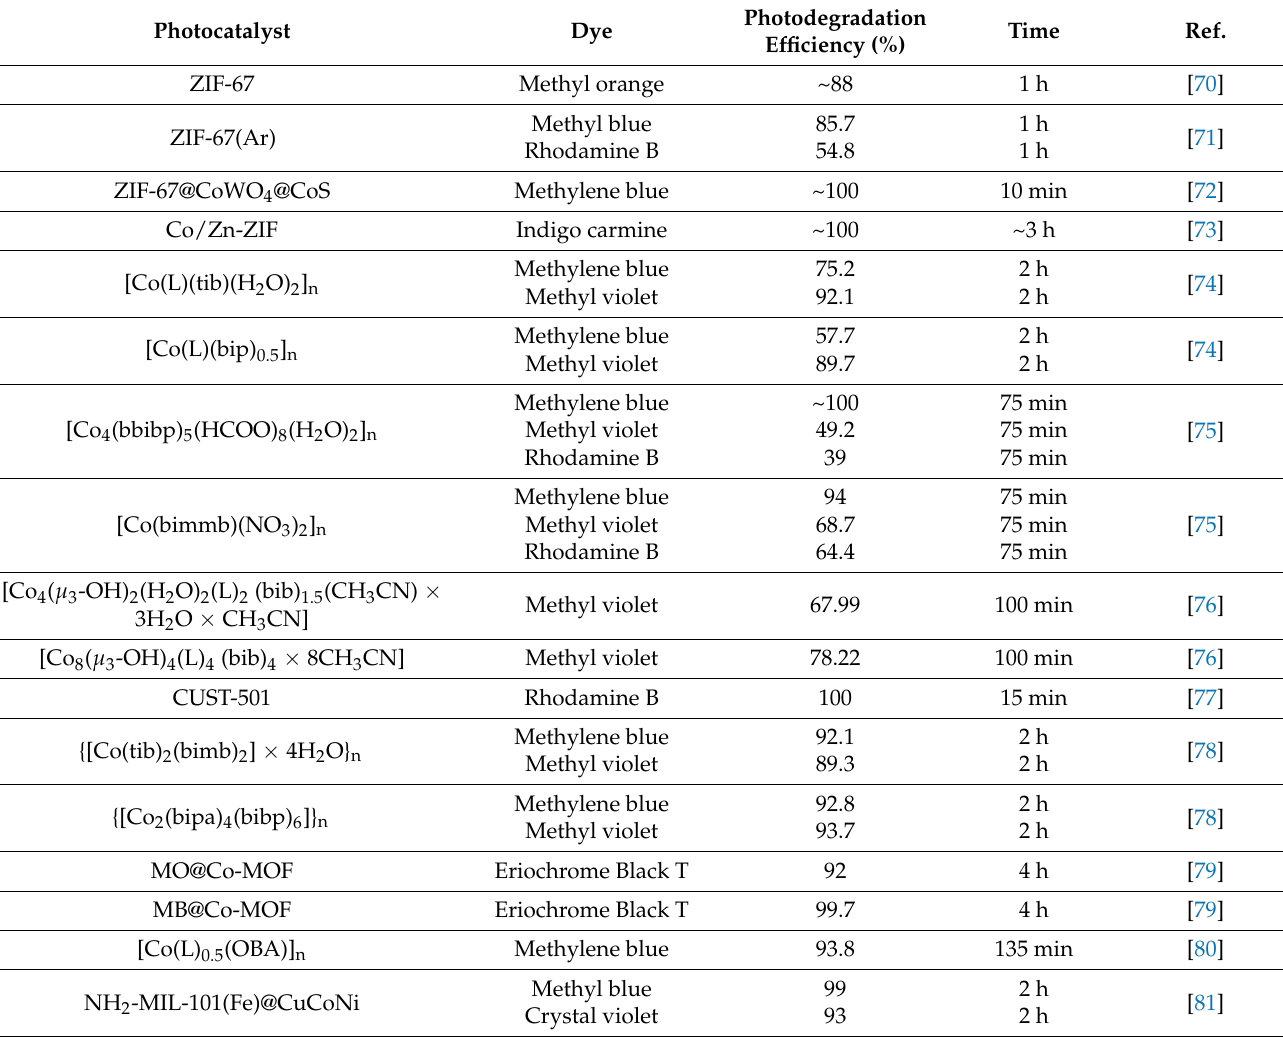
Table 1. Examples of Co-based MOFs used in the photocatalytic degradation of various dyes. Photocatalyst